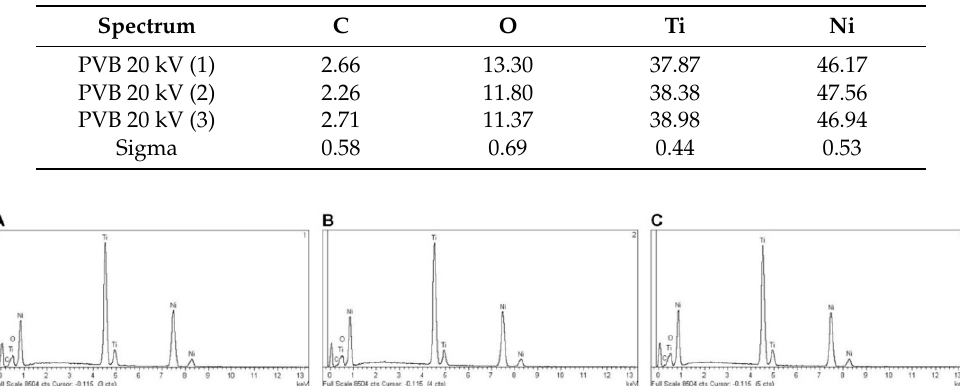
Table 8. Mean atomic weight percent (%) of CM-Blue Wire PVB endodontic rotary files at 15 kV and 20 kV at three different locations (1, 2 and 3).